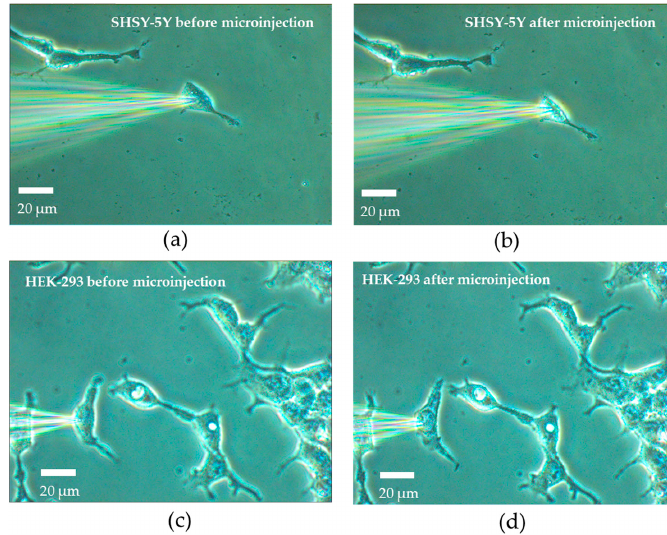
Figure 5. Photos of the micropipette and the cells: ( a ) SHSY-5Y cells before the microinjection; ( b ) SHSY-5Y cells after the microinjection; ( c ) HEK-293 cells before the microinjection; ( d ) HEK-293 cells after the microinjection.